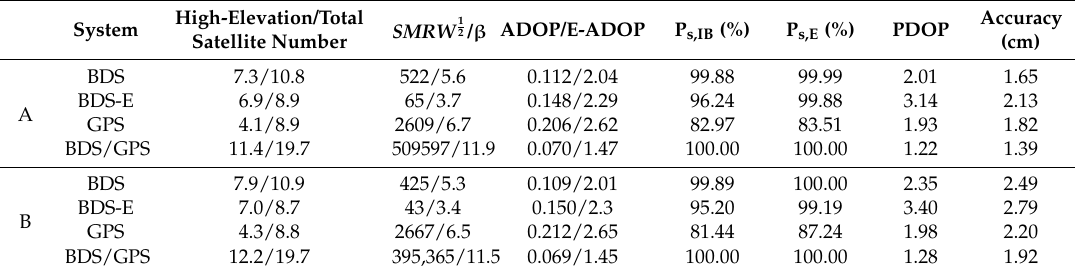
Table 4. Results of BDS, BDS-E, GPS and BDS/GPS for 10 km